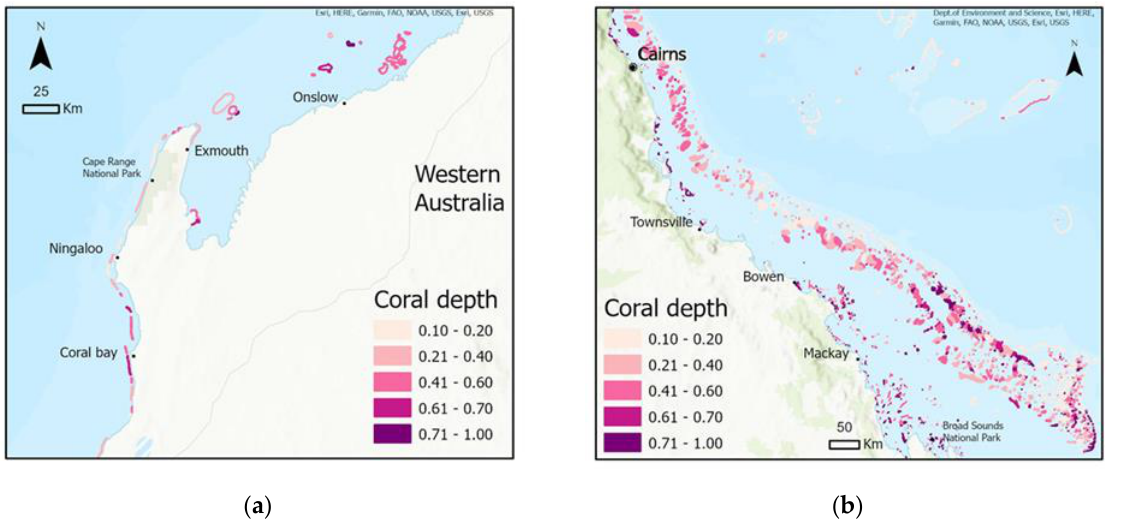
Figure 8. Vulnerability indicator maps of coral depth in the Ningaloo Reef ( a ) and the southern Great Barrier Reef ( b ). Higher (darker) values denote shallower depths at which corals are found.